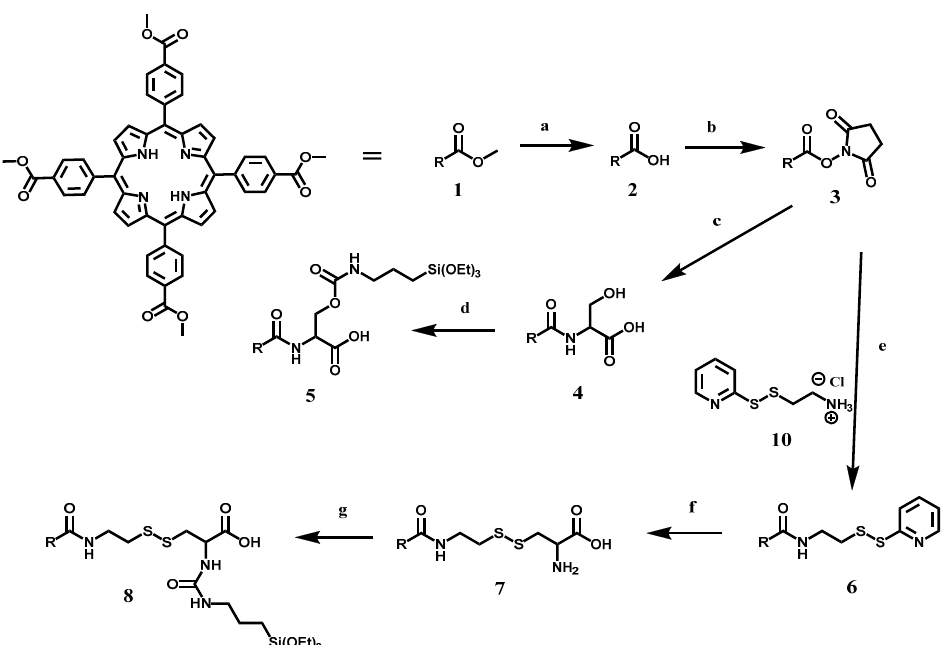
Scheme 3. Schematic representation of the synthesis of C-TCPP and RR-TCPP silane derivatives.